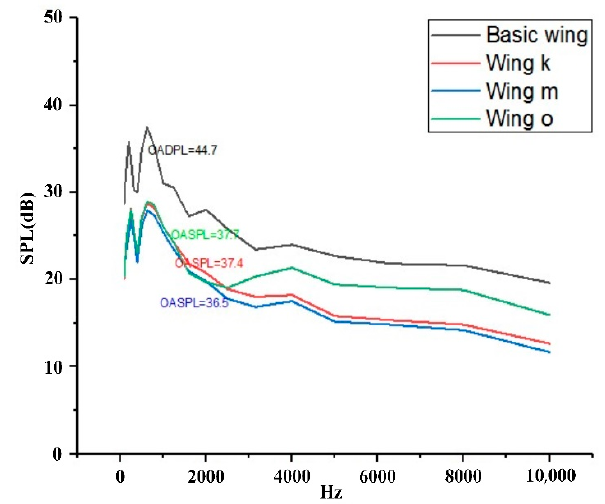
Figure 8. 1/3 octave sound pressure level curves of different bionic